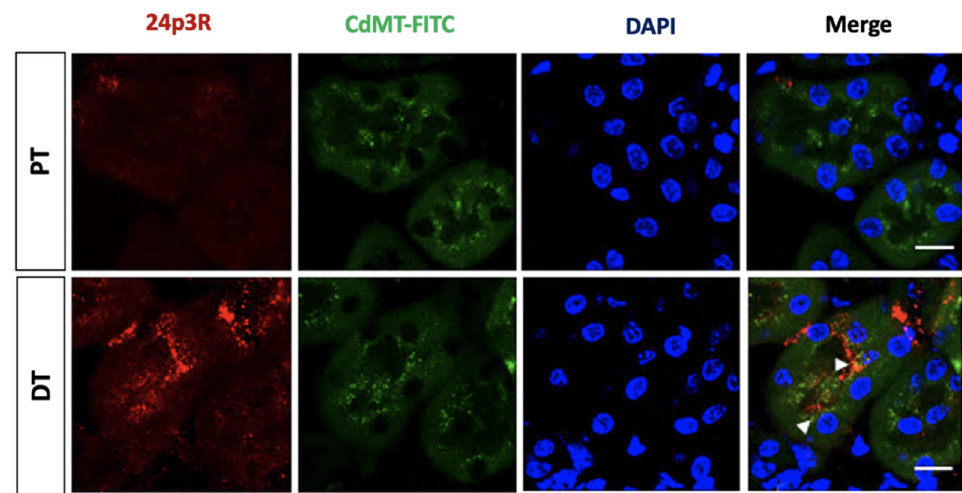
Figure 10. The CdMT-FITC complex is taken up by 24p3R negative PT and also co-localizes with DT cells expressing 24p3R (and possibly CD cells) in control mice. Nuclei are stained blue with DAPI. Scale Bar = 50 µm. White arrows point at the CdMT complex in 24p3R positive cells.